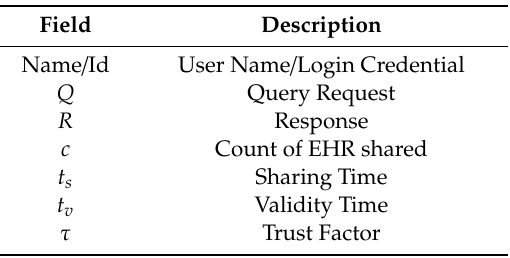
Figure 2. ( a ) Man-in-middle attack. ( b ) Data tampering attack. ( c ) Server-client based blockchain Figure2. ( a )Man-in-middleattack. ( b )Datatamperingattack. ( c )Server-clientbasedblockchaintechnology. technology. Table 1. Blockchain